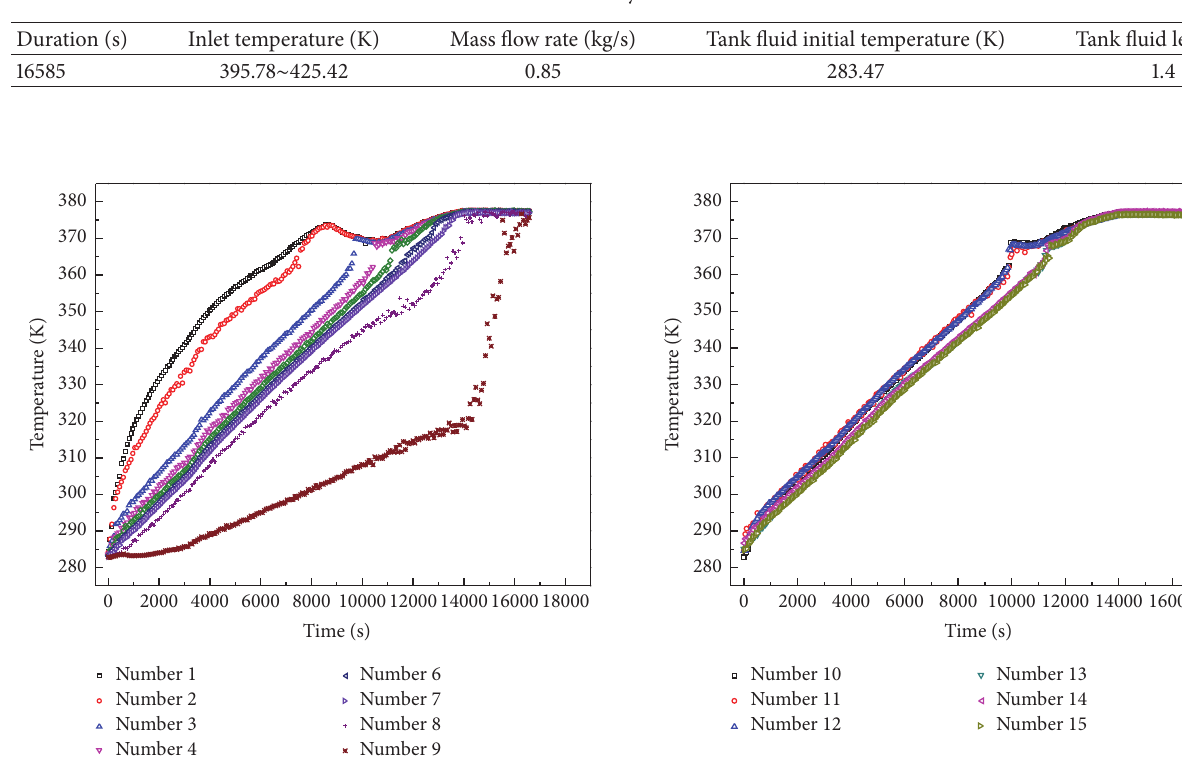
Figure 4: Temperature distribution in the horizontal direction of the water